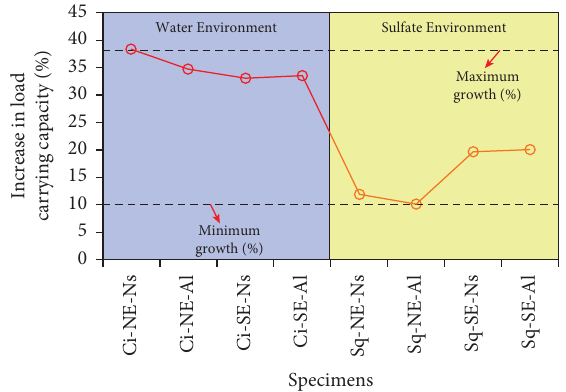
Figure 10: Te percentage increase in the bearing capacity of circular and square columns retroftted with the proposed jacket compared to the control samples.